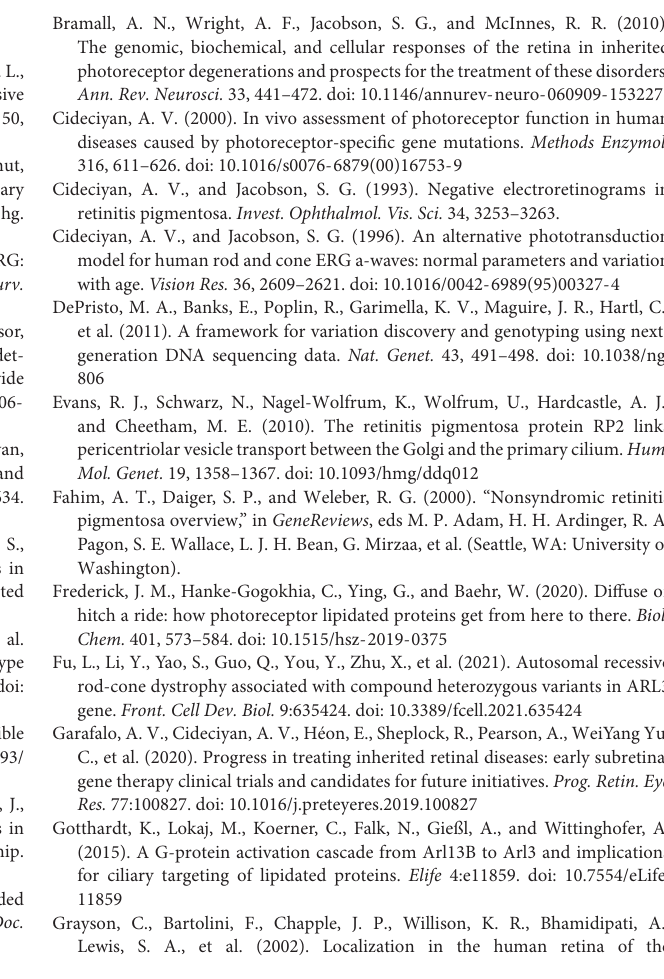
Supplementary Figure 1 | (A) Visual acuity as a function of age in five members of the ARL3 family. Longitudinal data are shown as symbols connected by lines. (B) Visual acuities in four of the patients replotted as a function of years after an estimated onset of decline in acuity. The dashed line corresponds to the group decline in acuity (0.029 logMAR/year or 6.9% per year; n = 8 eyes, mixed-effects